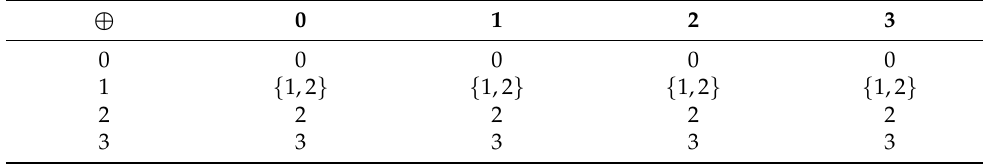
Table 16. Semihypergroup derived from Table